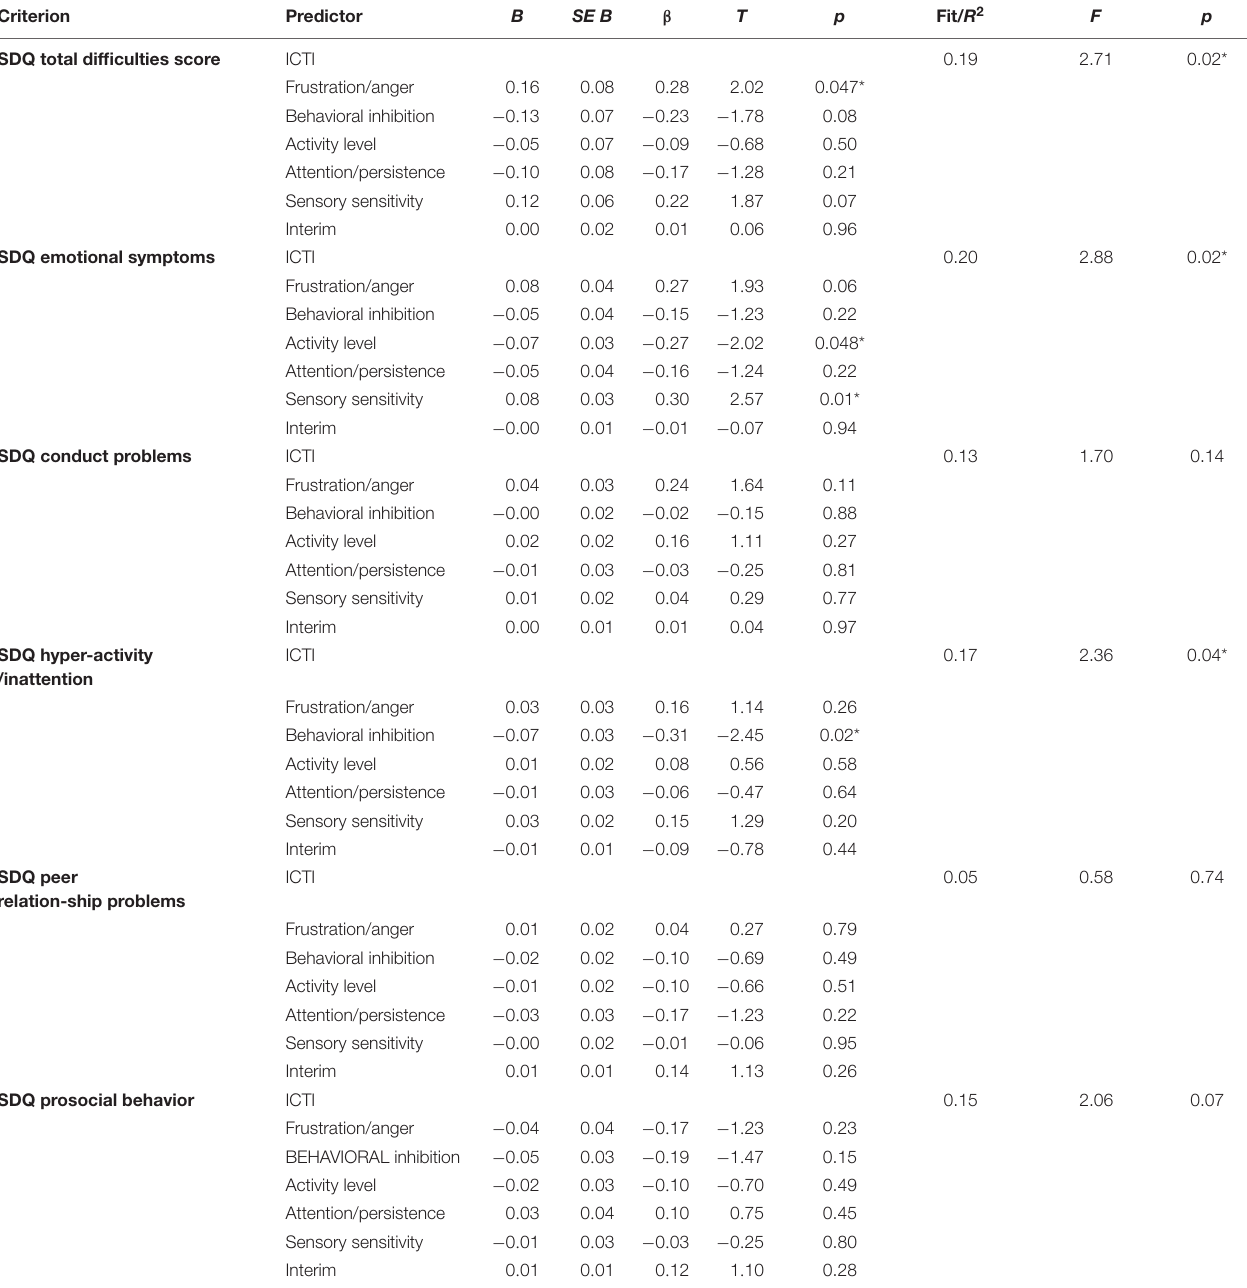
TABLE 5 | Multiple Regressions results using ICTI temperament traits and interim (time between t1 and t2) as predictors of SDQ ( n = 76).